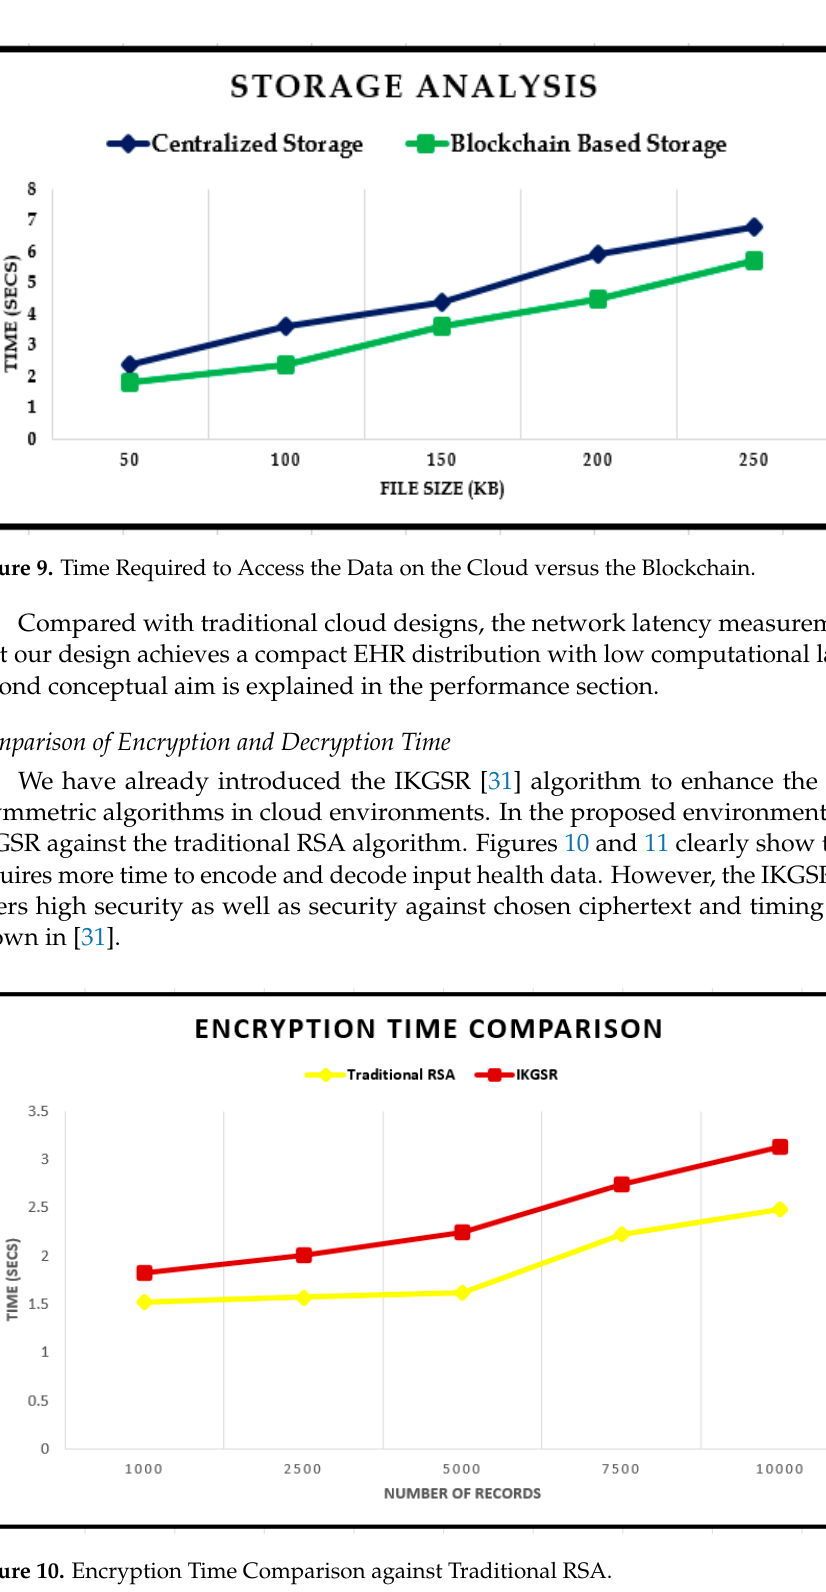
Figure 11. Decryption Time Comparison against Traditional RSA. 7. Security Evaluation Security is a major concern when implementing healthcare applications using vari- ous technologies; where sensitive data are protected from unauthorized access, the integ- rity of the data is enhanced, and the privacy of the users is enhanced. These assertions were used to demonstrate the trustworthiness of the proposed approach.